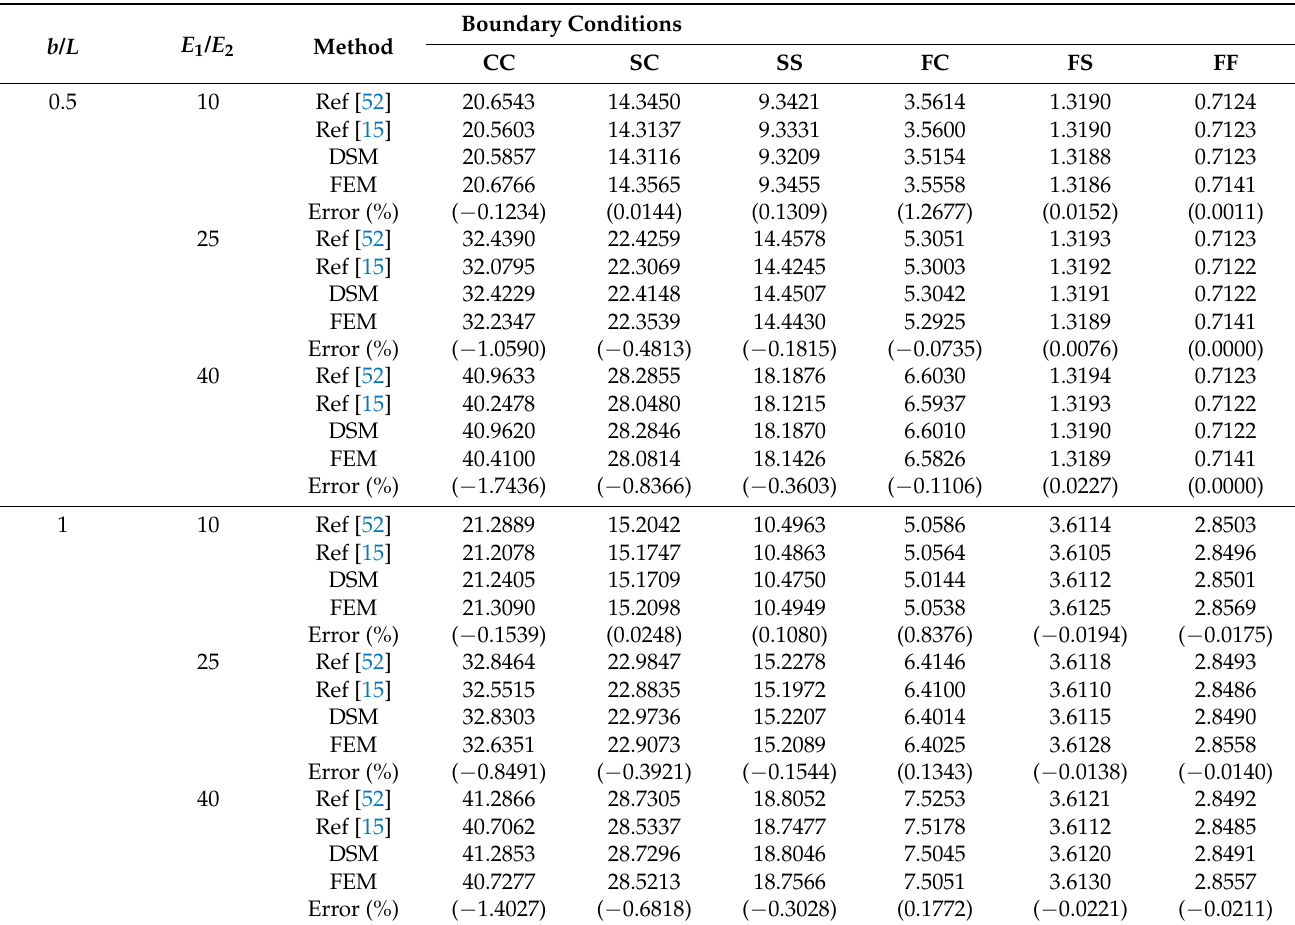
Table 1. Comparison of fundamental frequency parameters (cid:118) = ω b 2 thotropic plate ( b / h =